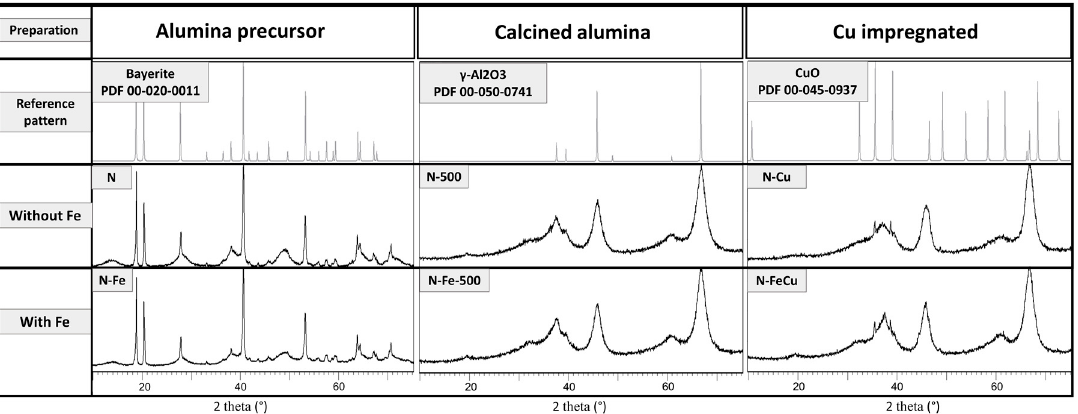
Figure 4. XRD patterns of alumina bayerite precursor “N” and alumina bayerite precursor with iron “N-Fe” (alumina precursor), calcined alumina “N-500” and calcined alumina with iron “N-Fe-500” (calcined alumina), Cu impregnated alumina “N-Cu” and Cu impregnated alumina with iron “N-FeCu” (Cu impregnated).